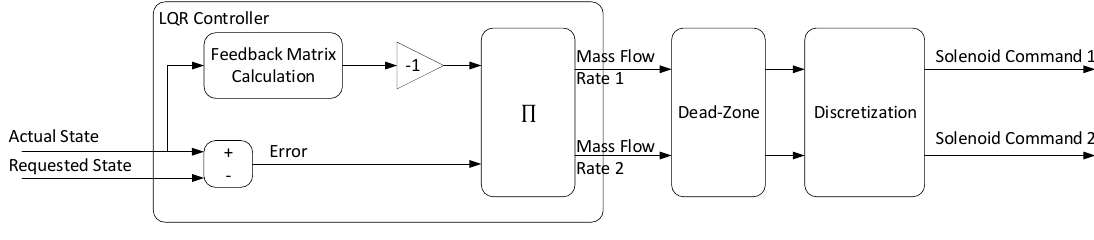
Figure 6. Layout of the Linear-Quadratic Regulators (LQR) controller.